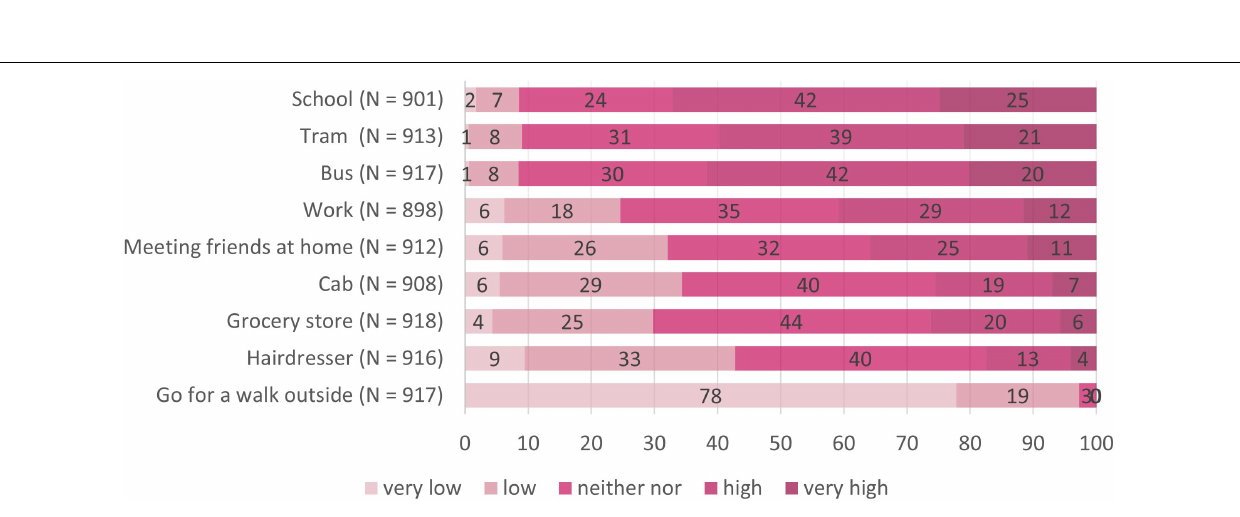
FIGURE 4 | Subjective risk perception in different day-to-day situations. N = 918; numbers on the bars represent percentages.